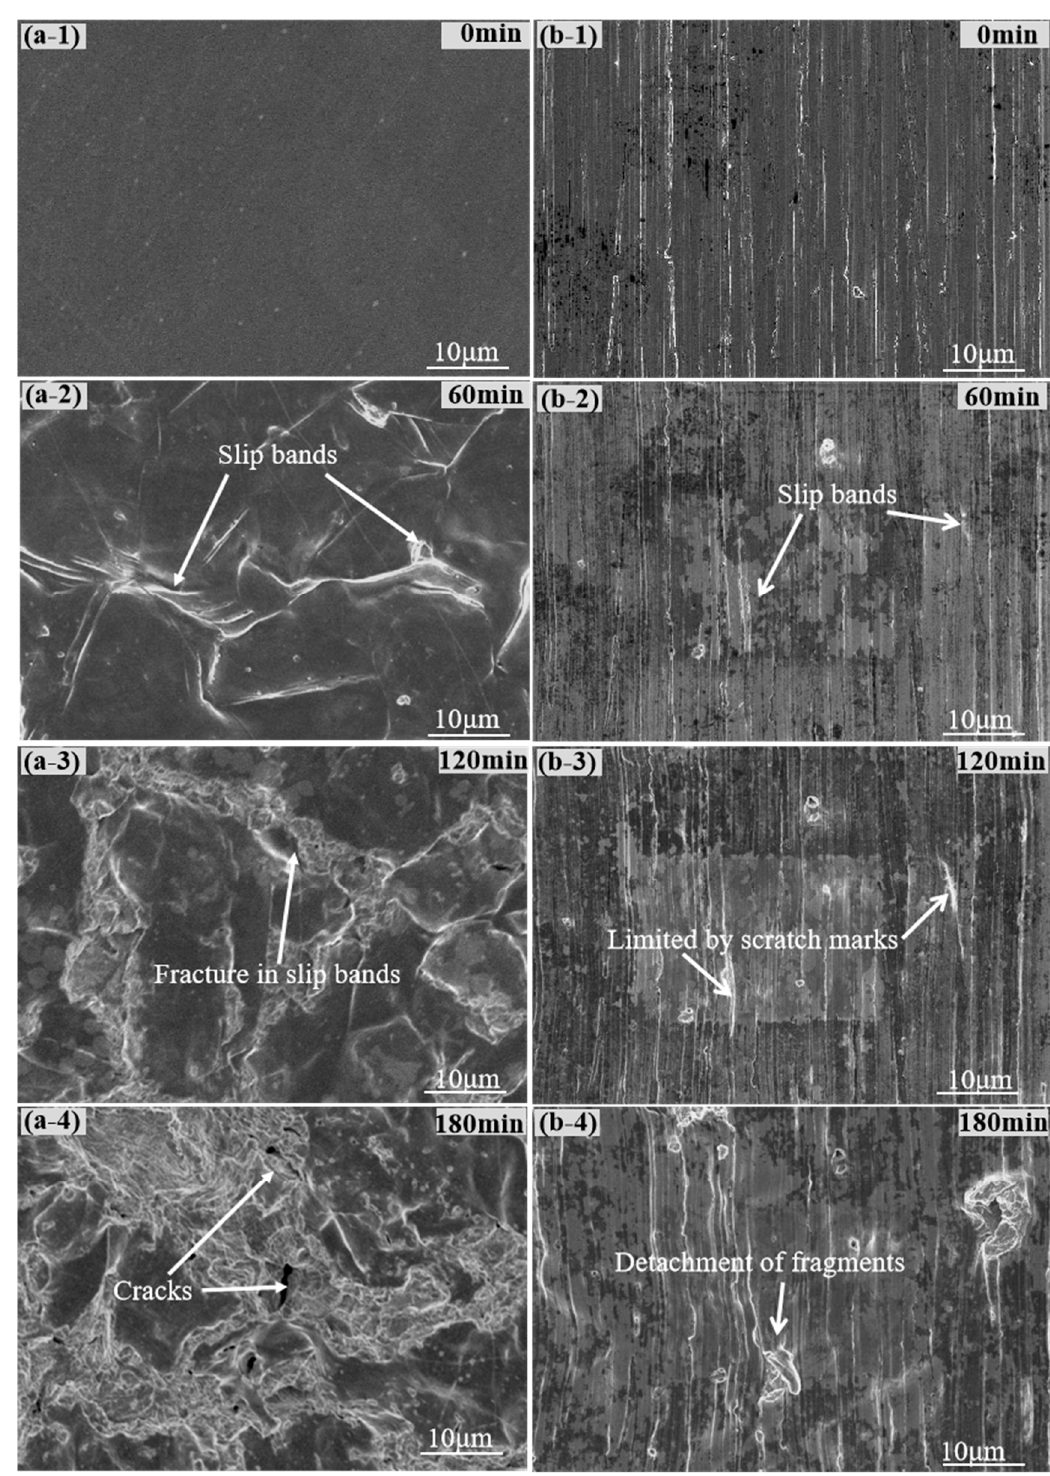
Figure 5. Surfaces of the 316L ( a-1 – a-4 ) and ground 316L ( b-1 – b-4 ) specimens before and after cavitation erosion.